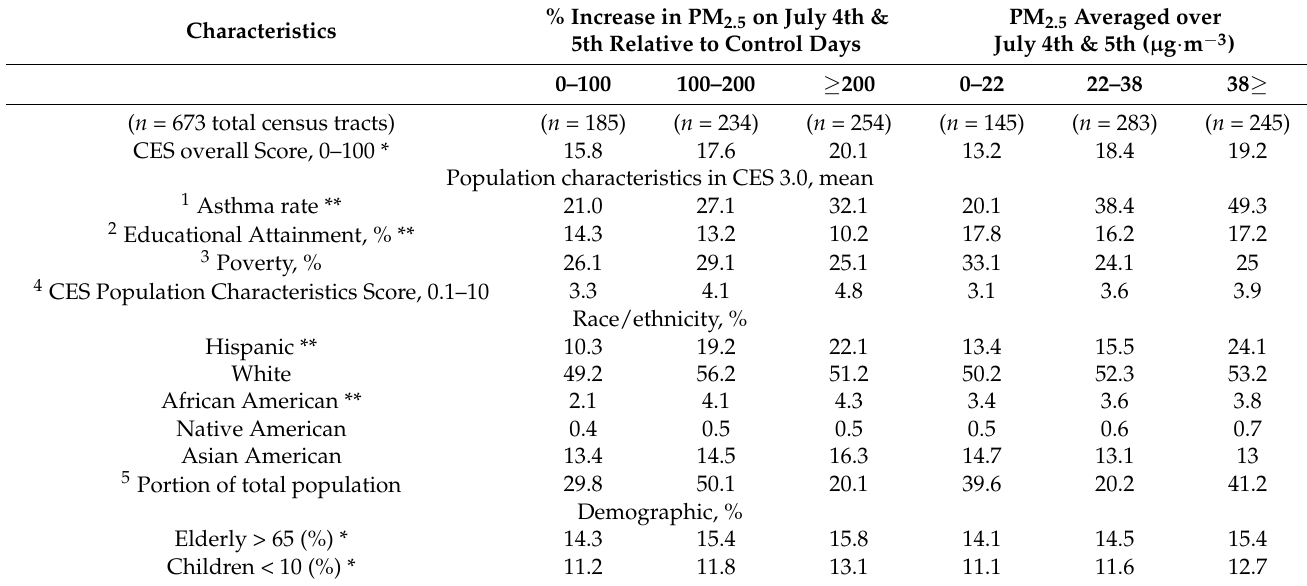
* Statistical significance of between-group differences in the results with a p -value < 0.1. ** Statistical significance of between-group differ- ences in the results with a p -value < 0.05. 1 Asthma rate: an age-adjusted rate of emergency department visits for asthma. 2 Educational Attainment: percent of the population over the age of 25 with less than a high school education. 3 Poverty: percent of the population living below two times the federal poverty level. 4 Population characteristics score: the value is derived for each census tract using the average percentiles for three vulnerable population indicators (asthma, cardiovascular disease, and low birth weight) and five socioeconomic indica- tors (educational attainment, housing burdened low-income households, linguistic isolation, poverty, and unemployment). The calculated average percentile is divided by 10 for a population characteristic score ranging from 0.1–10. 5 Percentage of total population: percentage of the total population of 673 census tracts across the state from which PM 2.5 concentration data was used for this